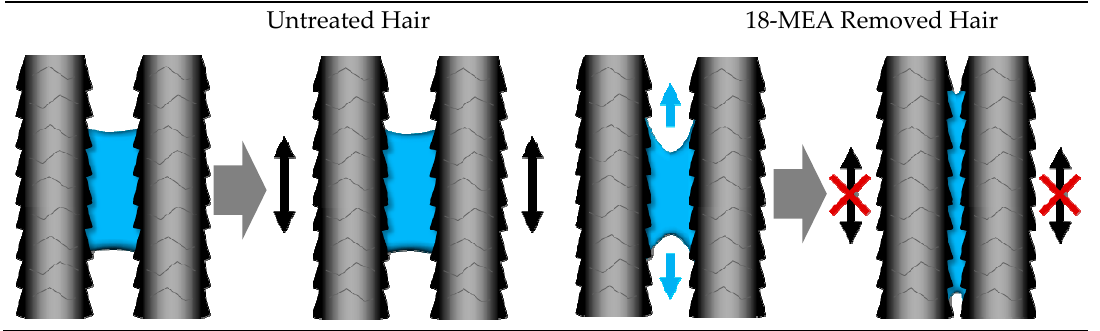
Figure 16. Schematic diagram of interactions between hair fibers in wet environment.